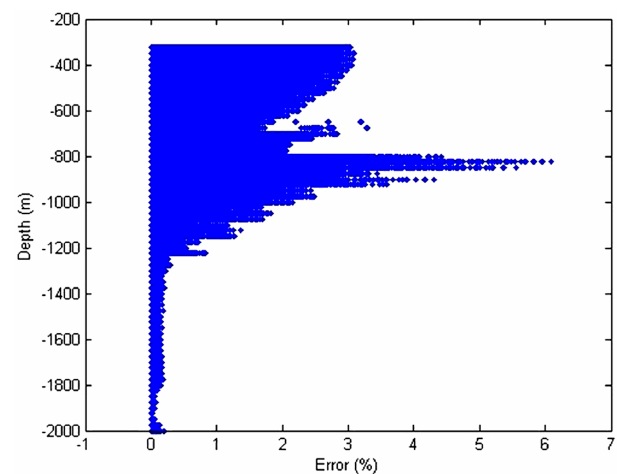
Figure 3. OMP mass conservation residuals ( R (cid:54) ). The residuals represent the difference between the theoretical value obtained with the result of the OMP analysis and the observed data.